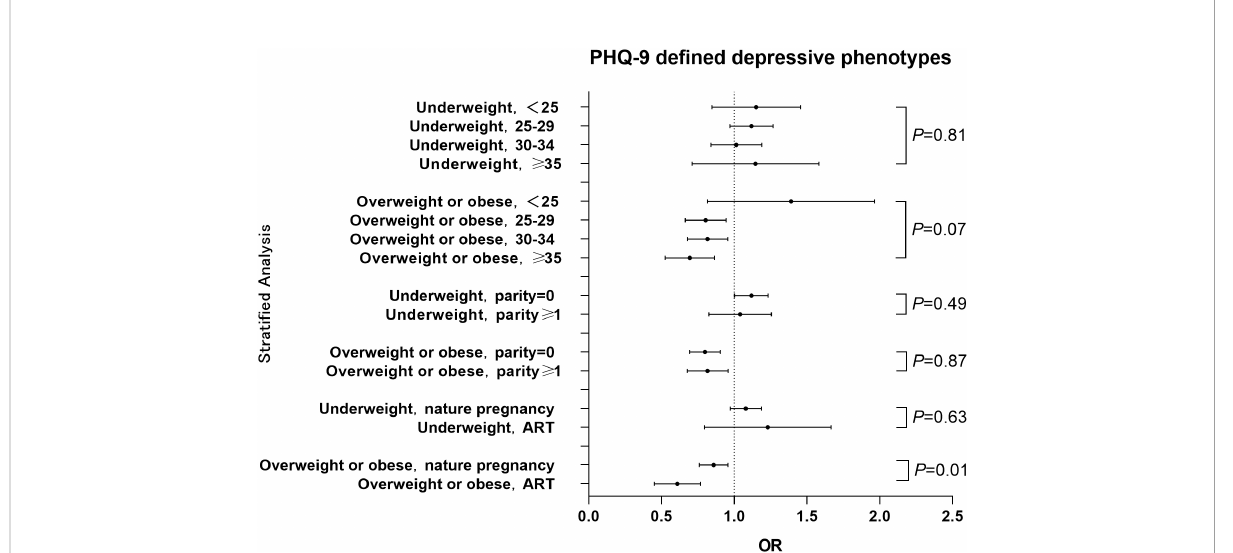
FIGURE 2 Hierarchical analysis of the association between pre-pregnancy BMI and PHQ-9 estimated depressive phenotypes among different stratums of age, parity history or way of conception The OR value for each stratum was calculated with comparison to the women with normal BMI. Pint refers to P for